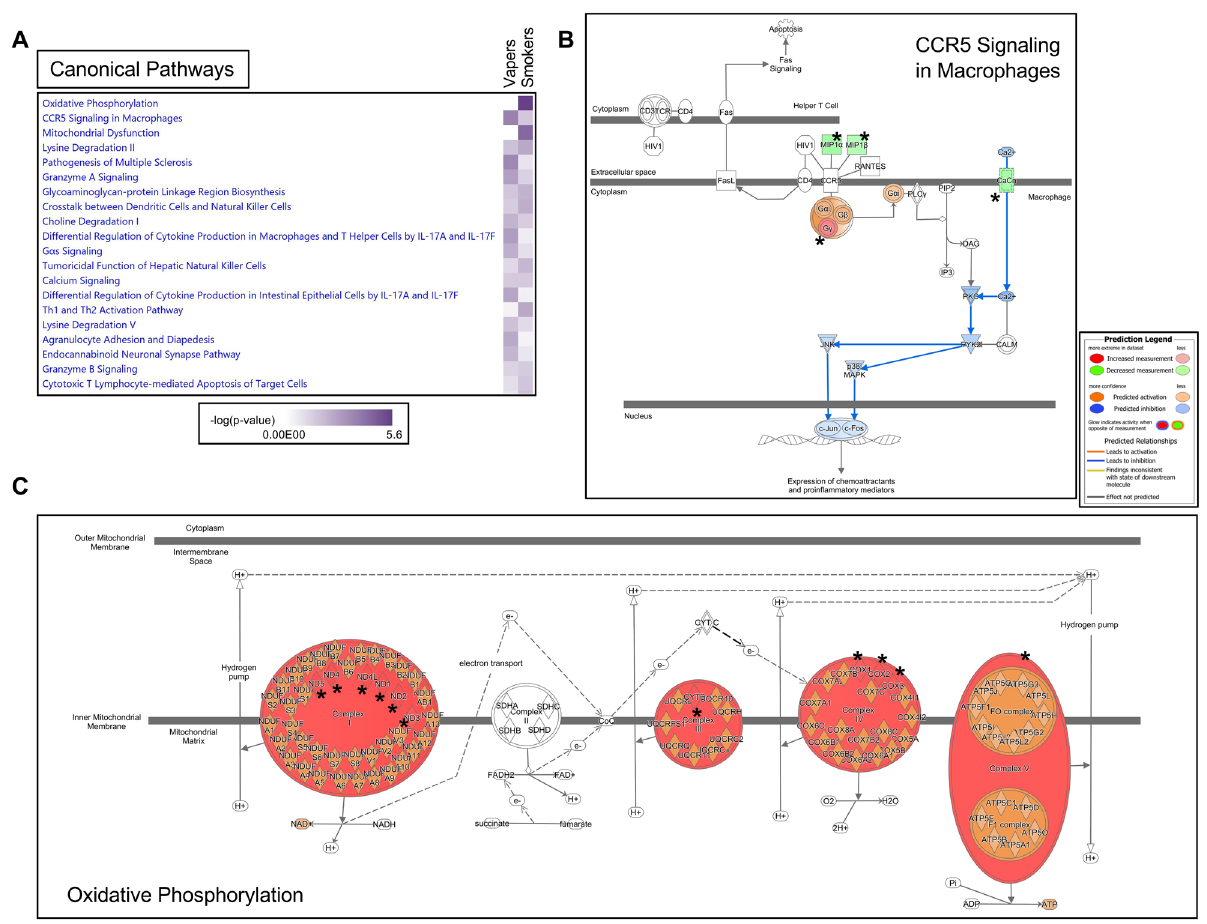
Figure 4. Canonical pathway analysis of differentially expressed genes in vapers and smokers by IPA. (A) Comparison Analysis was used to identify trends or similarities and differences across the datasets. The heatmap shows the top twenty canonical pathways impacted in vapers and smokers (based on P -value), allowing a direct comparison between the two groups. (B) The ‘ CCR5 signaling in macrophages ’ pathway was the top dysregulated pathway in vapers ( P = 2.15E−04). Affected molecules include CACNA2D2, CCL3/MIP1α, CCL4/MIP1β, and GNG11. (C) The ‘ Oxidative phosphorylation ’ pathway was the top disrupted pathway in smokers ( P = 2.80E−06). Affected molecules include ND1, ND2, ND3, ND4, ND4L, and ND5 (Complex I), Cyt b (Complex III), CO1, CO2, and CO3 (Complex IV), and ATP6 (Complex V). In both cases, Molecule Activity Predictor (MAP) analysis was used to predict how up-regulated and down-regulated genes in the datasets (red and green nodes, respectively) can affect the activity of other molecules on the pathway. For clarity, the affected genes are indicated by asterisks in the two pathways. Orange nodes, prediction of activation; blue nodes, prediction of pared to controls. Of the 92 aberrantly expressed transcripts in vapers, 81 (88.0%) mapped to known IDs, while 523 out of the 683 dysregulated transcripts in smokers (76.6%) had an assigned ID. The ‘Comparison Analysis tool’ in IPA was utilized to identify biological trends or functional similarities and differences in DEGs between vapers and smokers. As shown in Fig. 4A, the ‘ C–C Motif Chemokine Receptor 5 (CCR5) signaling of macrophages ’ was the most affected pathway in vapers, suggesting an interplay between vaping and the inflammatory response ( P = 2.15E- 04). CCR5 is a 41-kDa cell surface G protein-coupled receptor expressed in lymphoid organs, such as thymus and spleen, as well as in peripheral blood leukocytes, specifically T cells, and macrophages 25,26 . Upon interaction with multiple ligands, including the cognate ligands CCL3/MIP1α and CCL4/ MIP1β (transcriptionally down regulated in vapers in our dataset), CCR5 regulates leukocyte chemotaxis in inflammation 25,26 . Based on IPA prediction analysis, CCR5 signaling activity is reduced in vapers (Fig. 4B). In smokers, the ‘ oxidative phospho- rylation ’ (OXPHOS) metabolic pathway was greatly dysregulated, affecting 11 of the 13 mitochondrial protein- coding genes (84.6%) (Fig. 4A). These genes encode protein subunits of the enzyme complexes of the oxidative phosphorylation system, which enables mitochondria to act as the powerhouses of our cells 24 . The affected genes express six subunits of the respiratory chain complex I (ND1, ND2, ND3, ND4, ND4L, and ND5), one subunit of complex III (Cyt b), three subunits of complex IV (CO1, CO2, CO3), and one subunit of complex V (ATP6) ( P = 2.80E−06) (Fig. 4C). The observed increase in MT-gene expression in both smokers and vapers suggests induction of mitochondrial dysfunction and damage in these groups. This may represent a feedback response